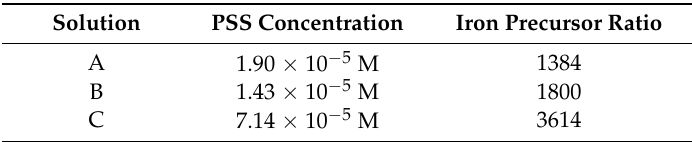
Table 1. PSS (polystyrene-4-sulfonate) concentrations and iron precursor ratios used to obtain each PSS-stabilised magnetite